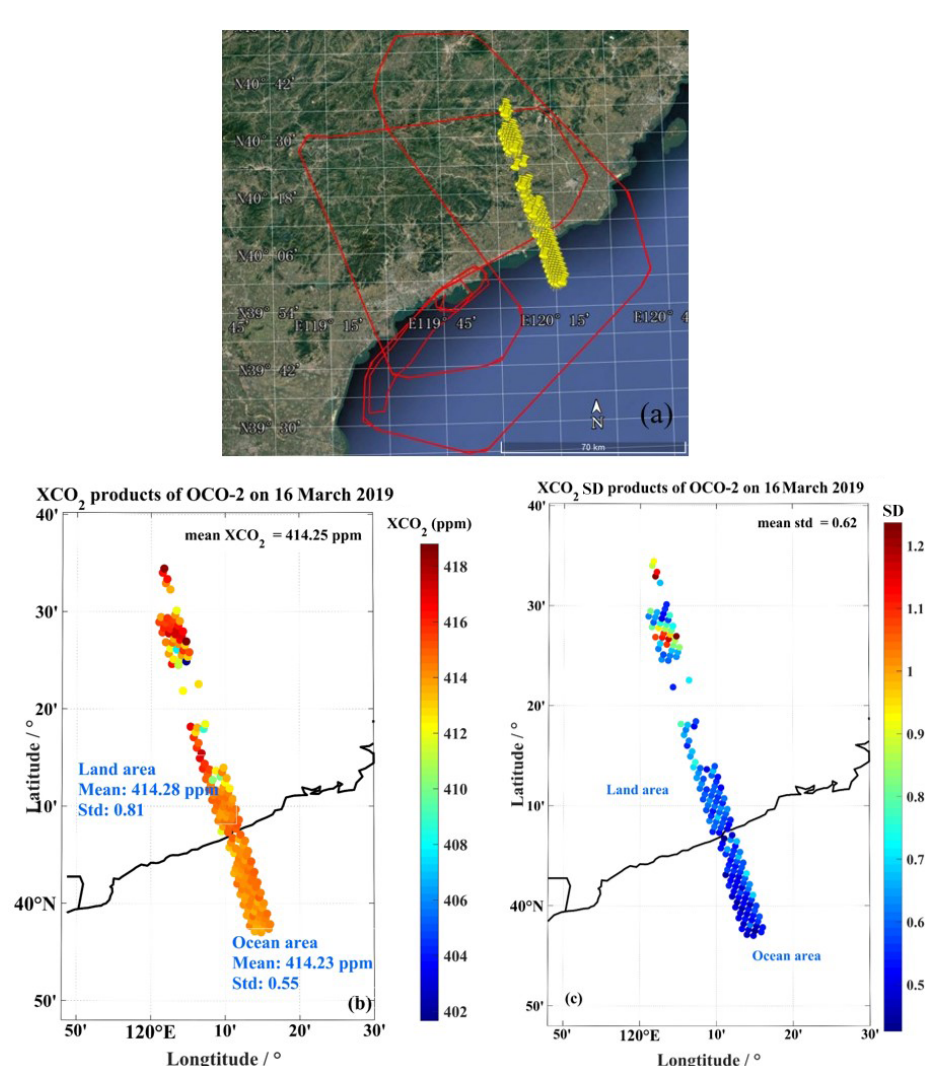
Figure 18. Orbit and detection results of OCO-2 satellite on 16 March. The solid red line in (a) is the flight path of the aircraft. The yellow marker point is the position of the suborbital point of the OCO-2 trajectory in the flight area (© Google Earth Pro). Panel (b) shows the XCO 2 results detected by OCO-2. Panel (c) shows the corresponding standard